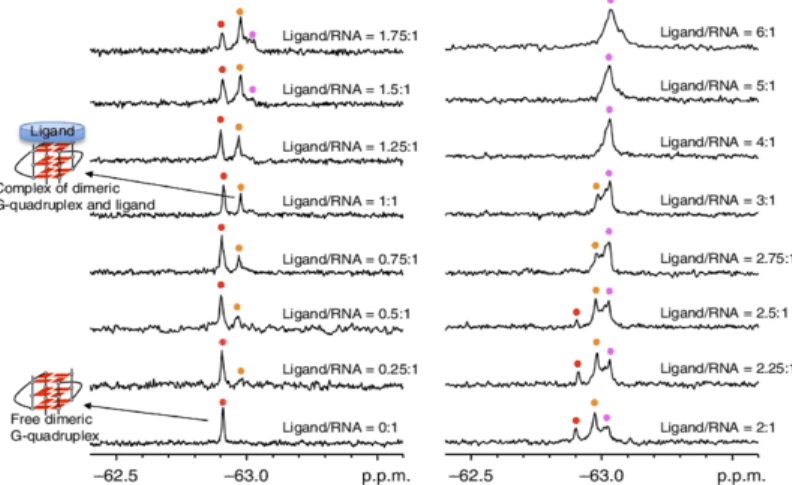
Figure 14. 19 F NMR spectra of 19 F-labeled 0.5 mM RNA ( 19 F-5 ′ -UAGGGUUAGGGU-3 ′ ) in 150 μ L of 90% H 2 O/10% D 2 O, 10 mM Tris-HCl buffer (pH 7.0), 50 mM KCl. titrated with PDS. Copyright (2017) Wiley. Reprinted with permission from ref. [159] Copyright 2017 John Wiley and Sons, Inc.